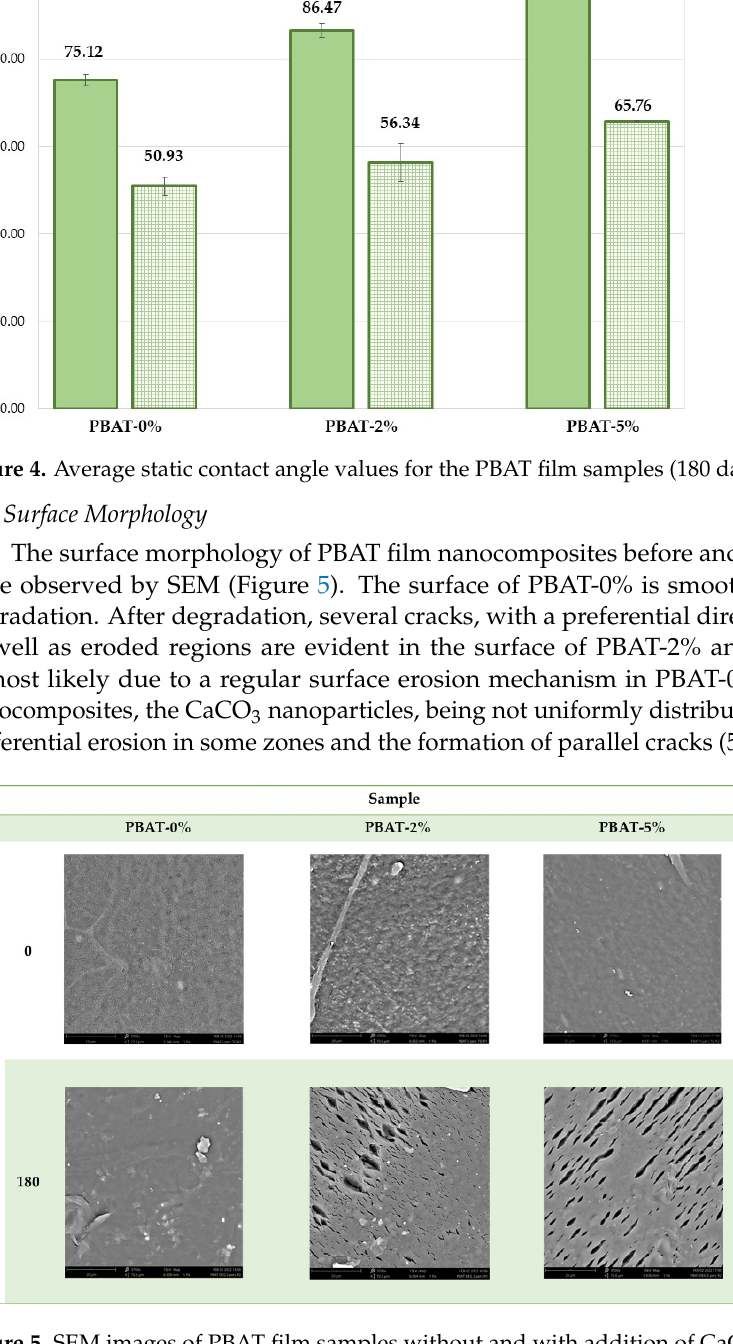
Figure 5. SEM images of PBAT film samples without and with addition of CaCO 3 , before and after soil burial degradation (180